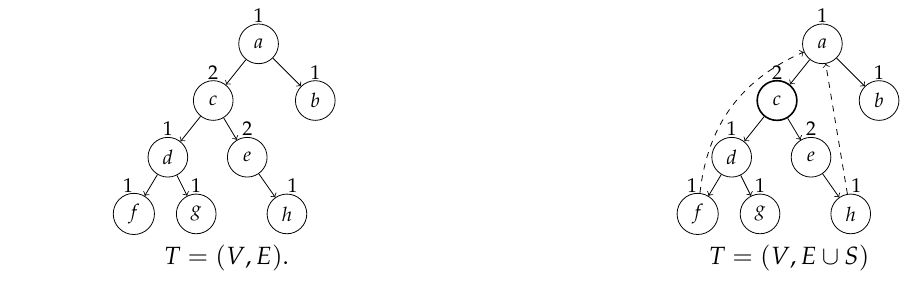
Figure 2. Consider the node c with w c = 2, p v = 1 ∀ v ∈ V and B = 2. We have: g ( d ,2 ) = 19, g ( d ,1 ) = 12, and g ( e ,1 ) = 7 + 2 ( 6 ) = 19. Therefore g ( c ,2 ) = g ( e ,1 ) + g ( d ,1 ) + w c · ( p ( T ( a )) − p ( T ( c ))) =